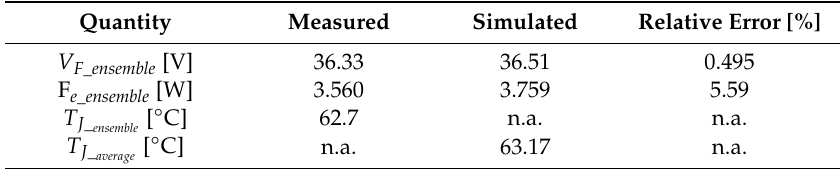
Table 6. Measured and simulated ‘ensemble’ properties of the investigated CoB LED device (400 mA driving current, 25 ◦ C ambient